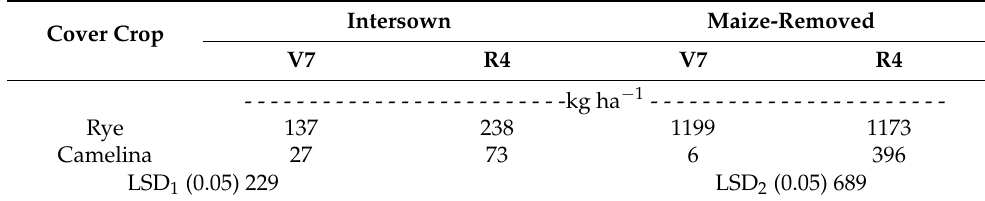
Least significant difference (LSD 1 ) to compare between means of cover crop species for the same sowing date and maize-removal method. LSD 2 to compare between means of sowing dates for the same cover crop